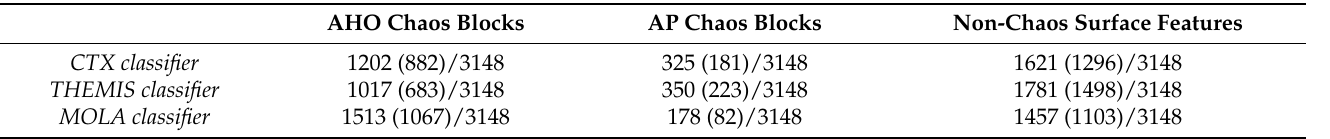
Table 3. Summary of the numbers of classified images pertaining to the CTX, THEMIS, and MOLA classifiers. The numbers in brackets represent the total numbers of classified images with probabilities of 80% or greater. AHO Chaos Blocks AP Chaos Blocks Non-Chaos Surface